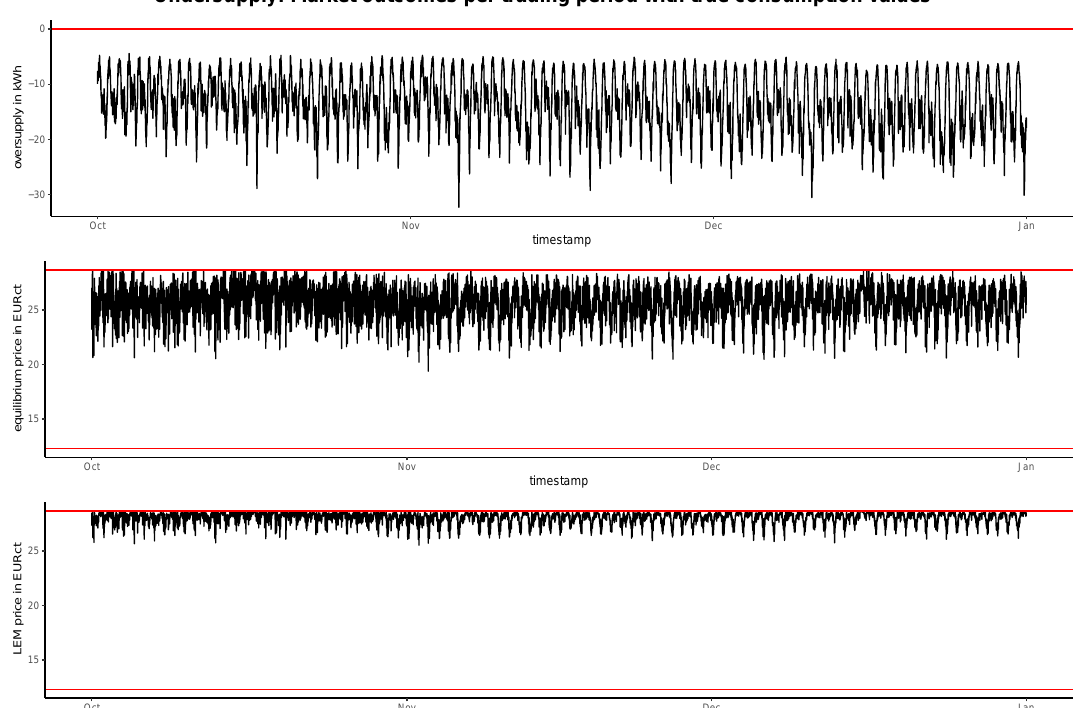
Figure 9. Market outcomes per trading period simulated with true values and an undersupply scenario. BLEMmarketSimulation